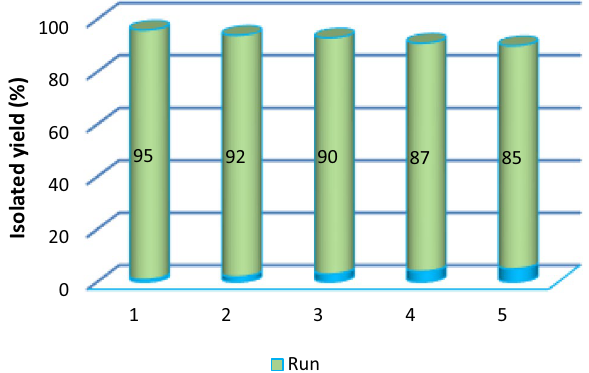
Figure 7. Reusability of the heterogeneous acidic nanocatalyst MCM-41-APS-PMDA-NHSO 3 H ( 1 ) for the synthesis of 5a .